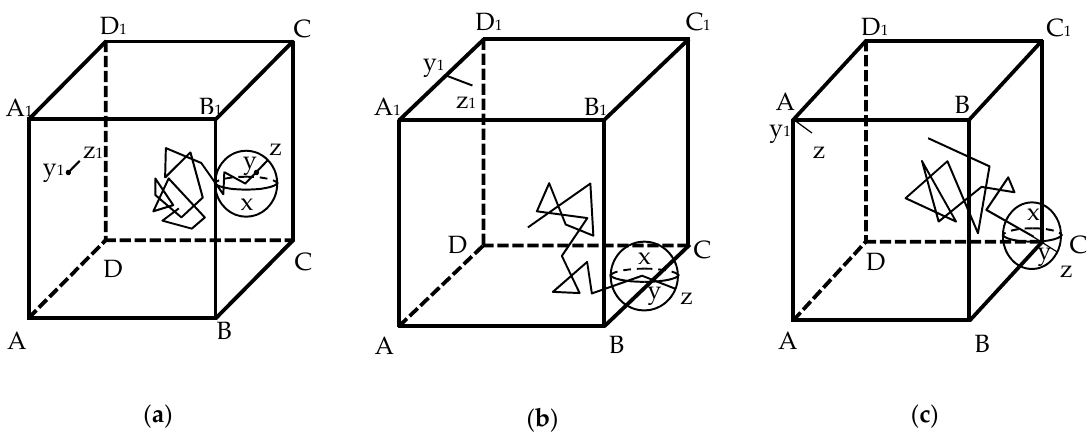
Figure 8. Brownian particle located close to ( a ) face; ( b ) edge; and ( c ) vertex.